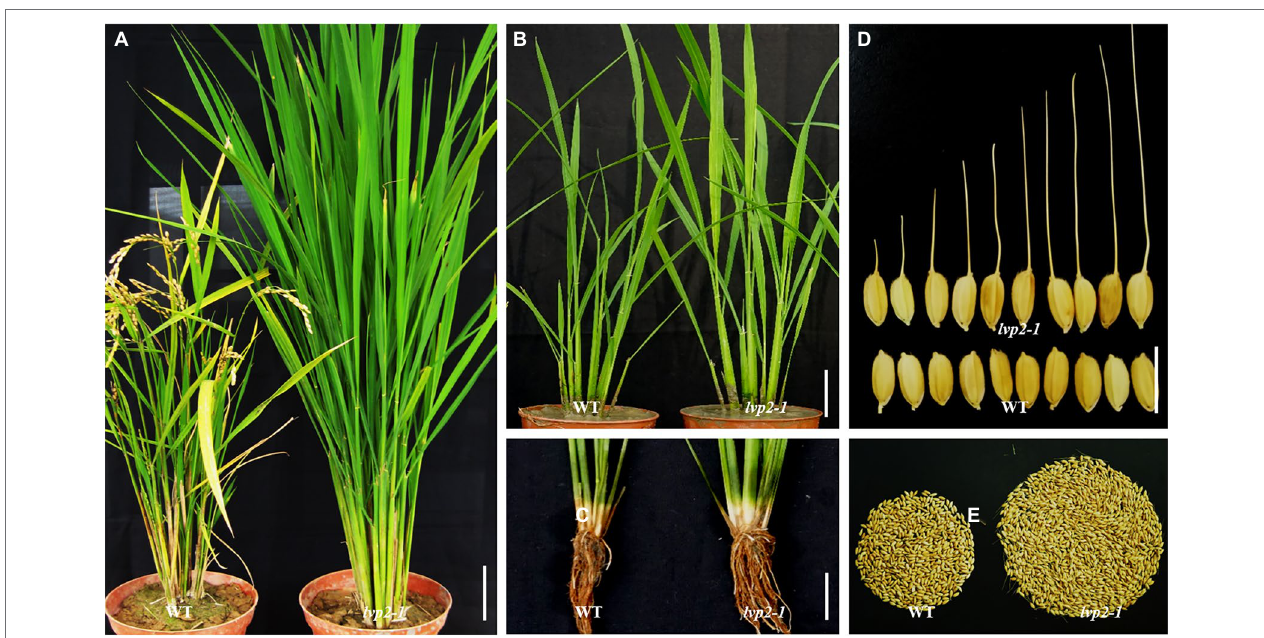
FIGURE 1 | Phenotypes of lvp2-1 and WT. (A) WT and lvp2-1 under natural day-length condition. (B,C) Plants (B) , roots and tillers (C) of WT and lvp2-1 at 45 days after sowing under NLD condition. (D) Sizes and shapes of WT and lvp2-1 seeds. (E) Seeds per plant of WT and lvp2-1 . Scale bars = 10 cm in (A-C) and 1 cm in (D) .